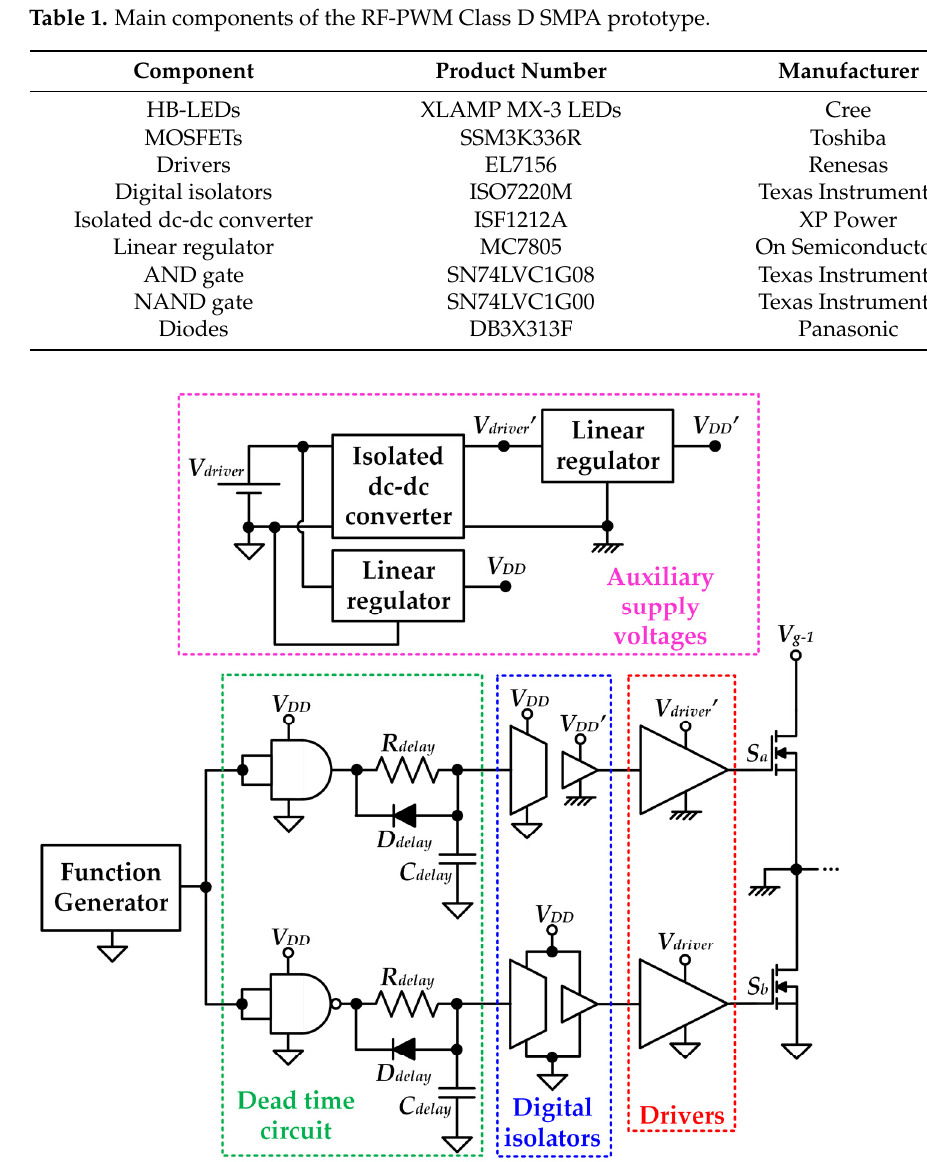
Figure 14. Scheme of the circuit in charge of driving the MOSFETs. Note that a power supply provides V driver = 9 V.